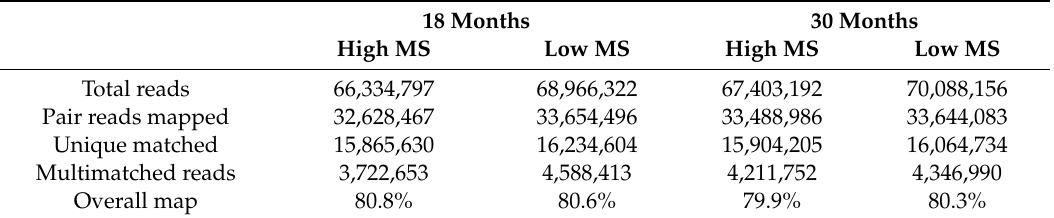
Table 1. Summary of sequencing reads aligned for low and high marbling (MS) at 18 and 30